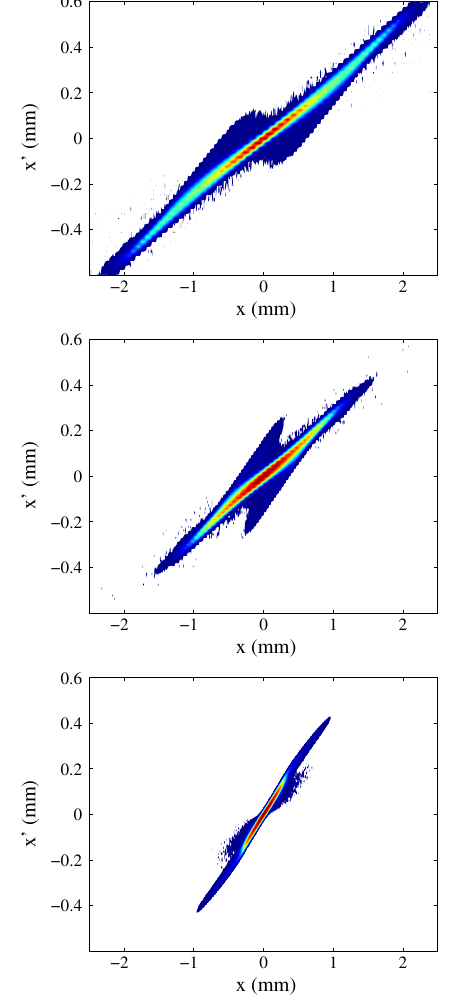
FIG. 8. Simulated transverse phase space at the location of EMSY1 for 2 nC (upper plot), 1 nC (middle plot), and 0.1 nC (bottom